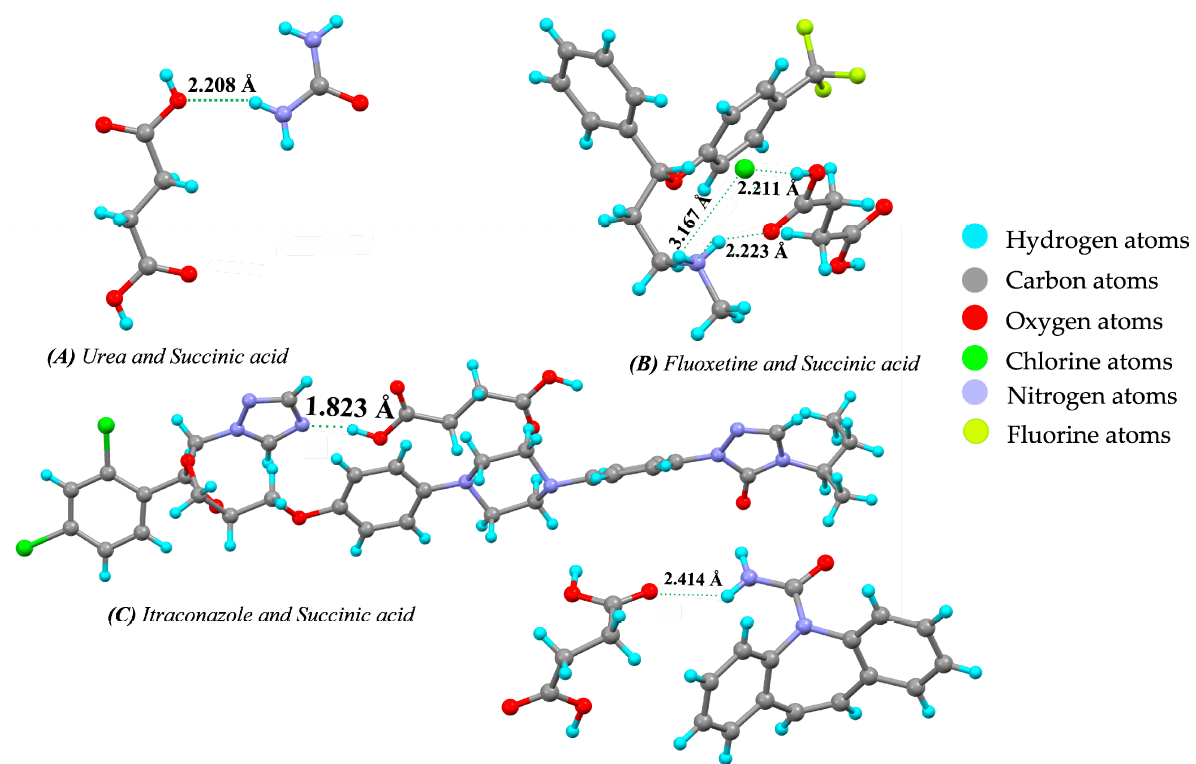
Figure 18. Hydrogen bond interaction and bond length between drug and coformer, represented as ( A ) Urea and Succinic acid (#795527), ( B ) Fluoxetine and Succinic acid (#254848), ( C ) Itraconazole and Succinic acid (#218567), and ( D ) Carbamazepine and Succinic acid (#671498) (from Mercury 2022.2.0 (Build 353591)). #—CCDC Identifier number.